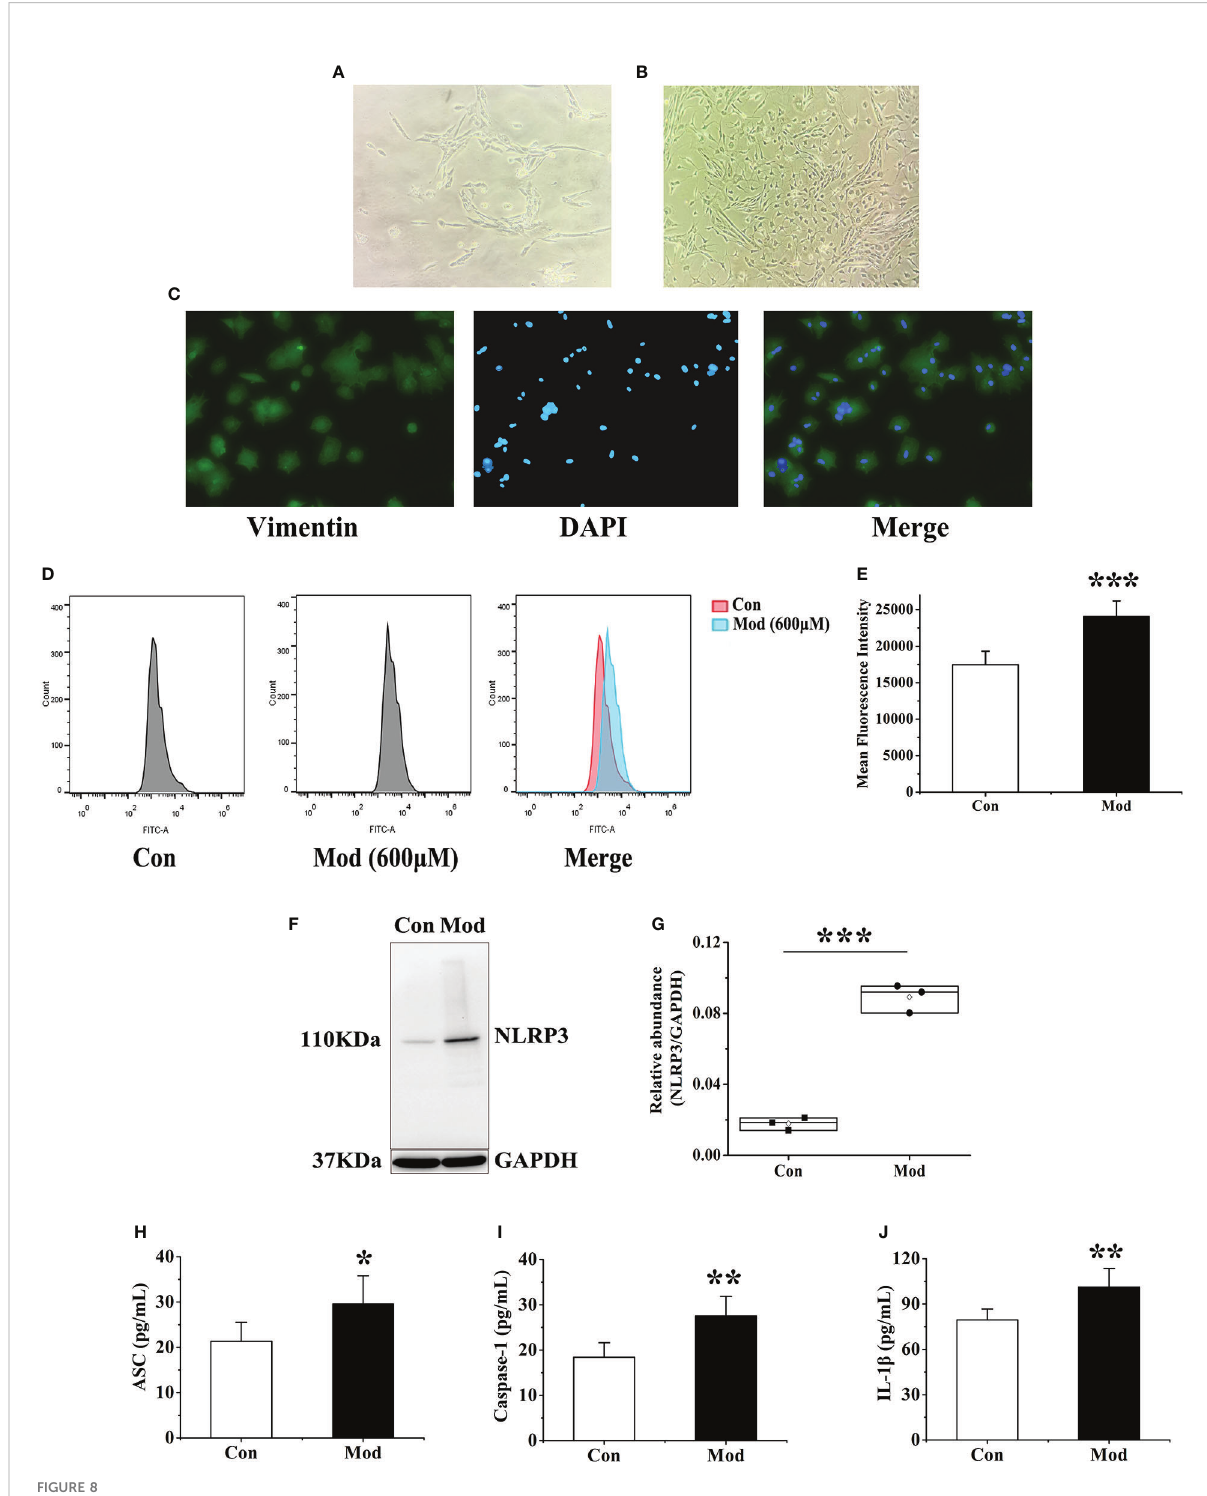
FIGURE 8 Extraction and identi fi cation of FLS and its effect on cellular ROS and NLRP3 in fl ammasome after uric acid treatment. (A) Morphology of the fi rst generation FLS. (B) Morphology of the third-generation FLS. (C) Vimentin identi fi es FLS as a characteristic labeling protein. (D) Detection of ROS expression levels in FLS after adding uric acid by fl ow cytometry. (E) The mean fl uorescence intensity of FLS in each group. (F) Western blot was conducted to evaluate the protein level of NLRP3 and GAPDH in cell lysates. (G) Box plot showing the densitometry analysis of NLRP3 normalized by GAPDH. (H) The expression level of ASC in cell supernatant. (I) The expression level of Caspase-1 in cell supernatant. (J) The expression level of IL-1 b in cell supernatant. * P < 0.05, ** P < 0.01 and *** P < 0.001 versus Con